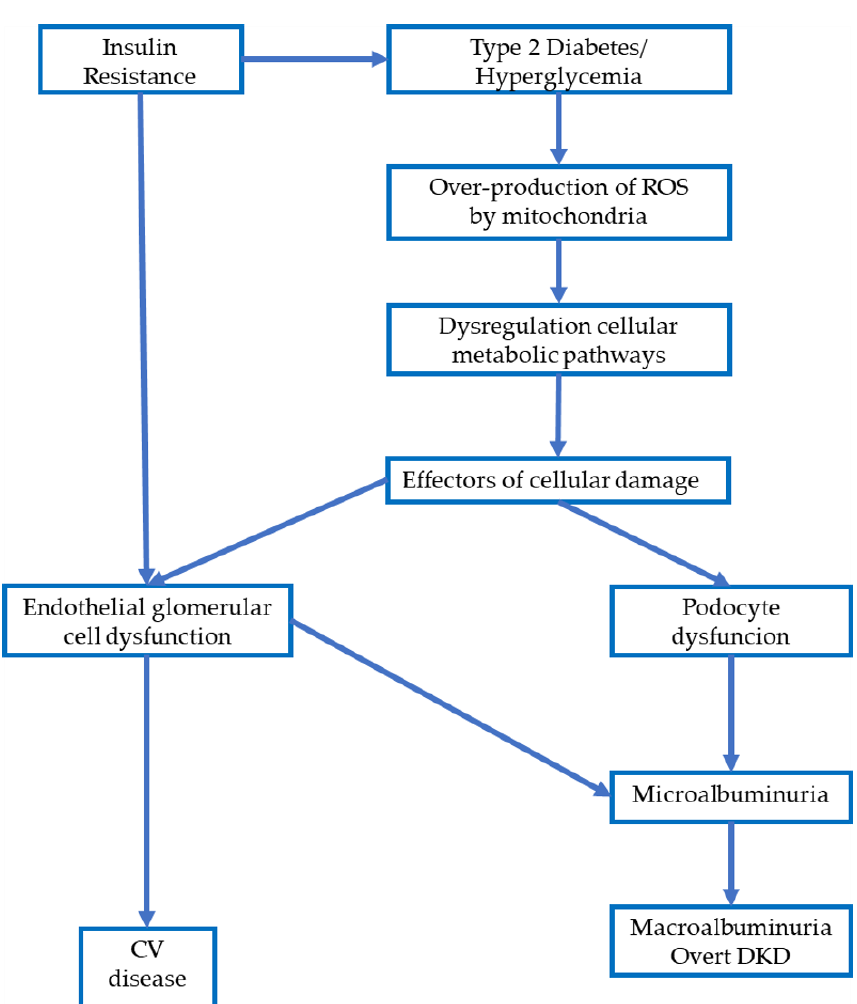
Figure 1. Pathophysiological cascade that describes the relationship between diabetes, endothelial damage, microalbuminuria, Diabetic Kidney Disease (DKD) and cardiovascular (CV) disease.